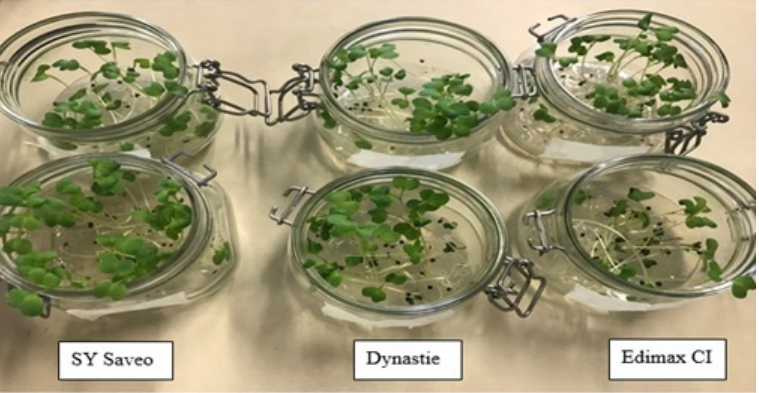
Figure 5. Rapeseed seedlings of the cultivars (Controls below; exposed to 80 mM NaCl above). Seedling growth was evaluated by measuring shoot length and longest root length.